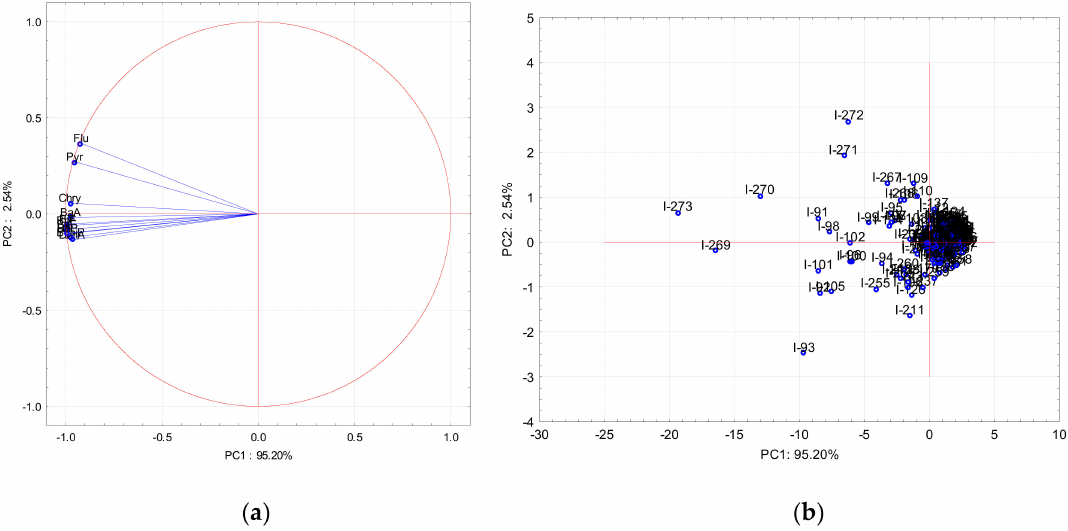
Figure 7. PC1-PC2 loading ( a ) and score plot ( b ) during warm period. I-1 to I-365 are the numbers of